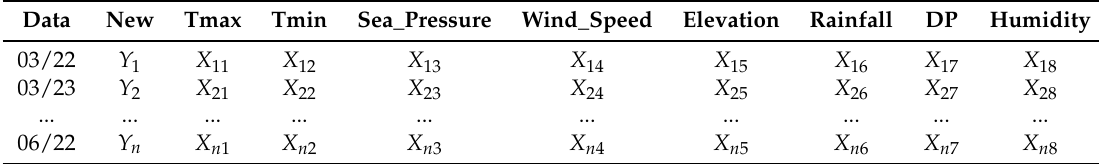
Table 1. Observation Variable